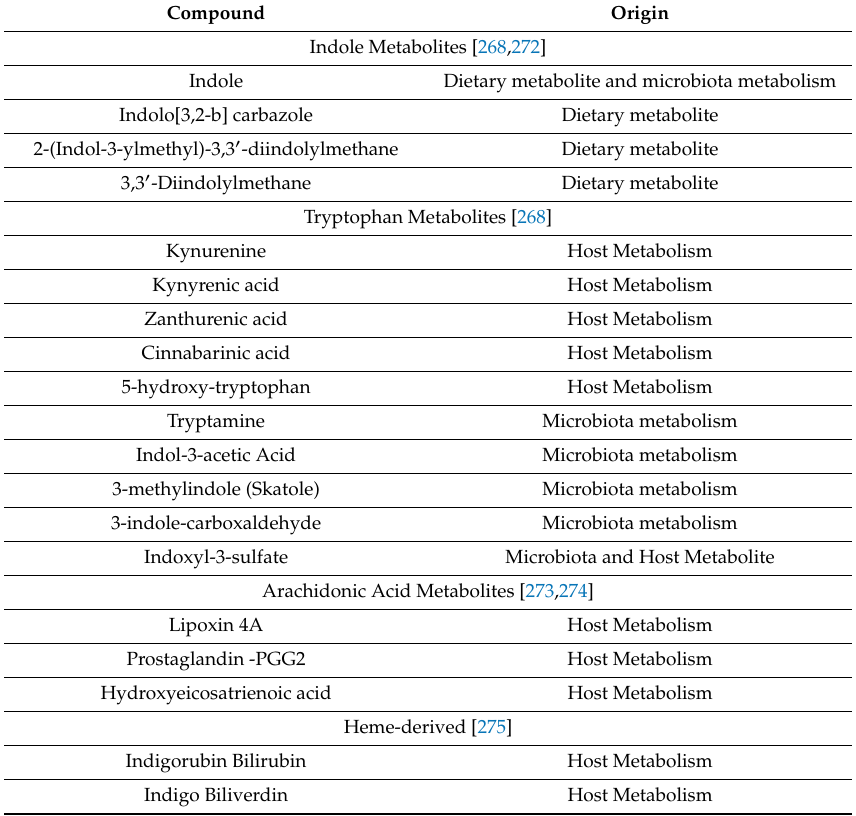
Table 5. Microbiota and host metabolites with AhR ligand properties (adapted from